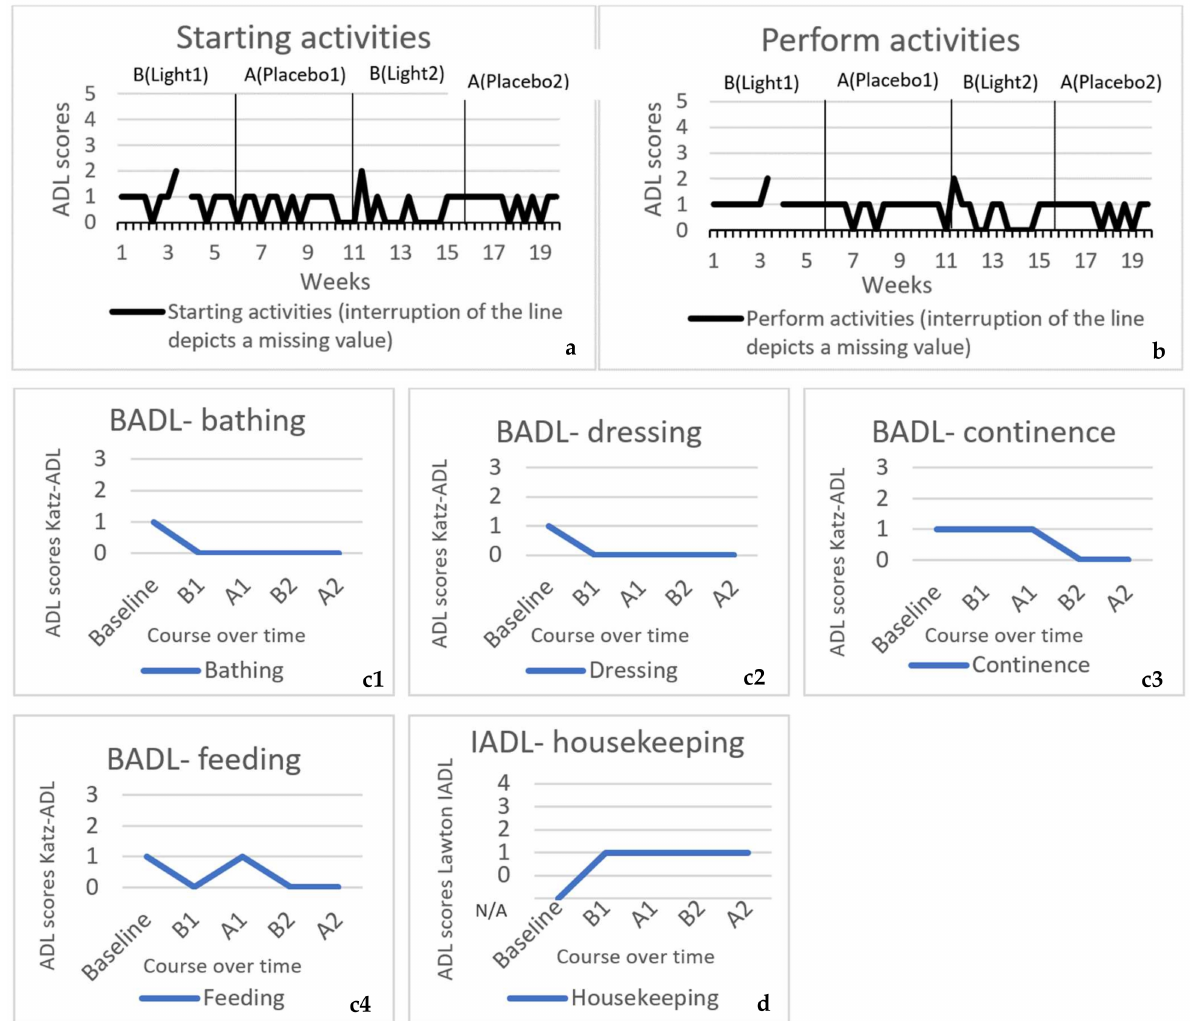
Figure 7. ( a ) Scores starting activities; ( b ) Scores perform activities; ( c1 – c4 ) Scores Katz-ADL; Baseline = before start of the first phase; B1 = scores at the end of intervention phase one; A1 = scores at the end of placebo phase one; B2 = scores at the end of intervention phase two; A2 = scores at the end of placebo phase two; ( d ) Scores Lawton IADL; Baseline = before start of the first phase; B1 = scores at the end of intervention phase one; A1 = scores at the end of placebo phase one; B2 = scores at the end of intervention phase two; A2 = scores at the end of placebo phase